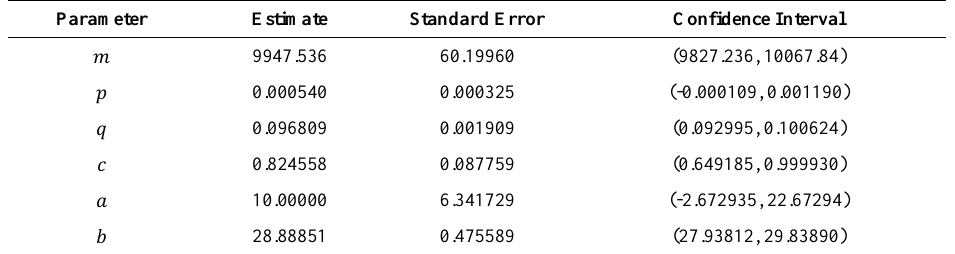
Table A20. Tuscany. Estimates, asymptotic standard errors and 95% mCIs for the parameters of the GBM 𝑹𝑬𝑪𝑻 (4)+(5).